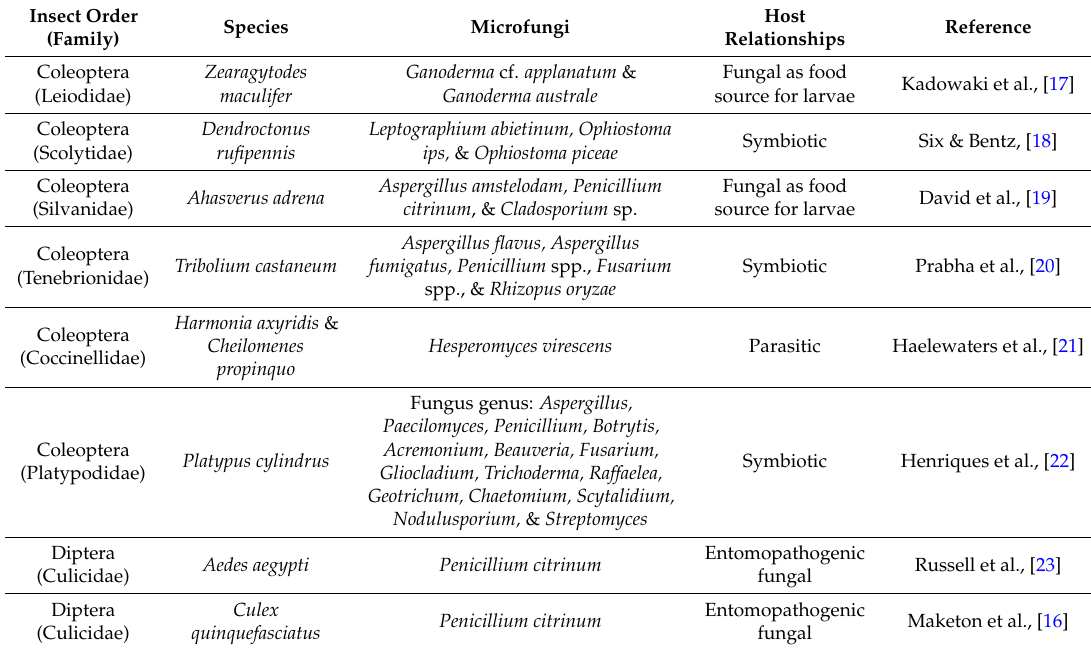
Table 1. Fungal diversity and their relationships with insects from